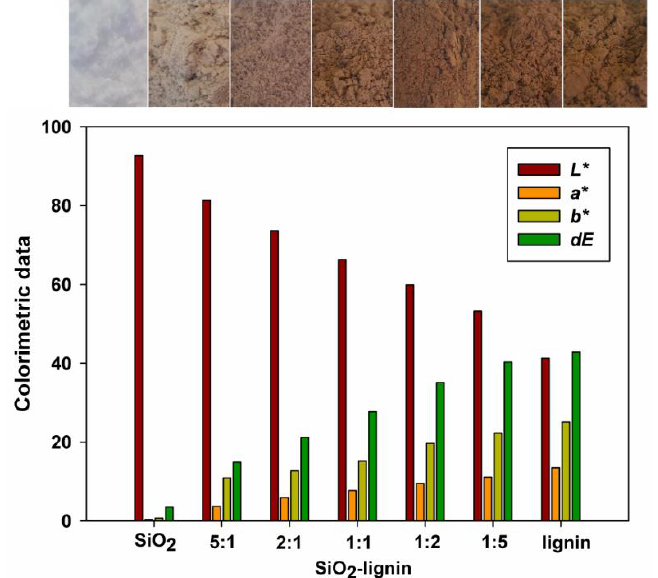
Figure 4. Colorimetric analysis of silica, lignin and silica-lignin hybrid materials with different weight ratios of the components used.